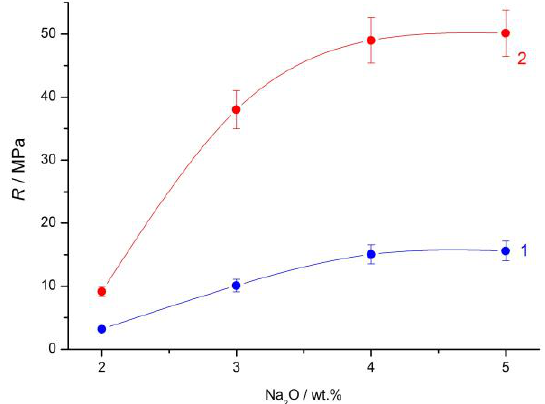
Figure 10. Compressive strengths ( R ) of alkali-activated binders prepared using antigorite-containing ore dressing tailings (AT) milled in air in moderate conditions for 240 s as a function of amount of added liquid glass. The modulus of liquid glass was 3.18. Curing time was 28 days. Hardening conditions were 1 : humid, or 2 : dry.